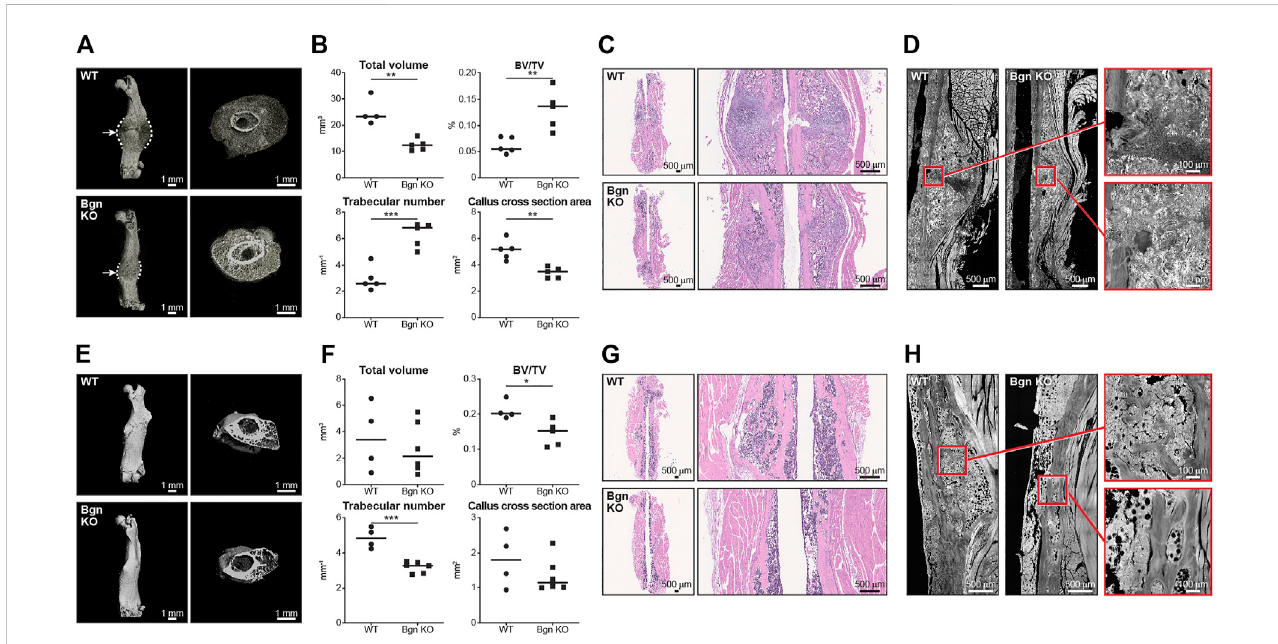
FIGURE 4 Lack of Bgn impairs bone healing after fracture. (A) 3D µCT reconstruction of femoral bone and cross section of the callus 2 weeks after fracture, representative images. Dashed lines mark the callus borders. Arrows marks the fracture site. (B) Quantitative µCT analysis of callus total volume, BV/TV, trabecular number and callus cross section area 2 weeks after fracture (n = 5 per group). (C) H&E staining of the callus area 2 weeks after fracture, representative images ( n = 5 per group). (D) SHG representative images of healing bone 2 weeks after fracture ( n = 5 per group). (E) 3D µCT reconstruction of femoral bone and cross section of the callus 8 weeks after fracture, representative images. (F) Quantitative µCT analysis of callus total volume, BV/TV, trabecular number and callus cross section area 8 weeks after fracture ( n = 4/5 per group). (G) H&E staining of the callus area 8 weeks after fracture, representative images ( n = 4/5 per group). (H) SHG representative images of the newly regenerated bone 8 weeks after fracture ( n = 4/5 per